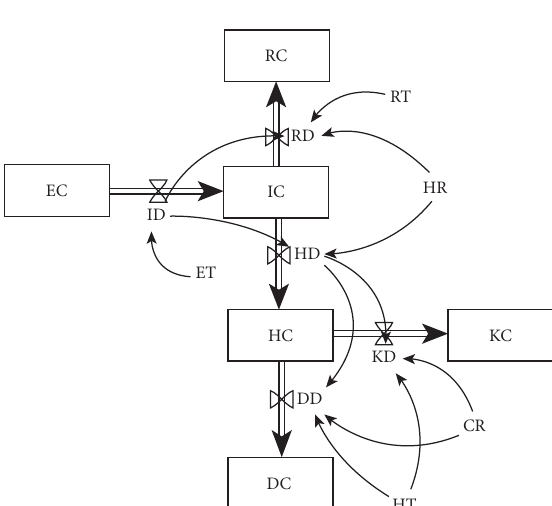
Figure 6: Medical subsystem